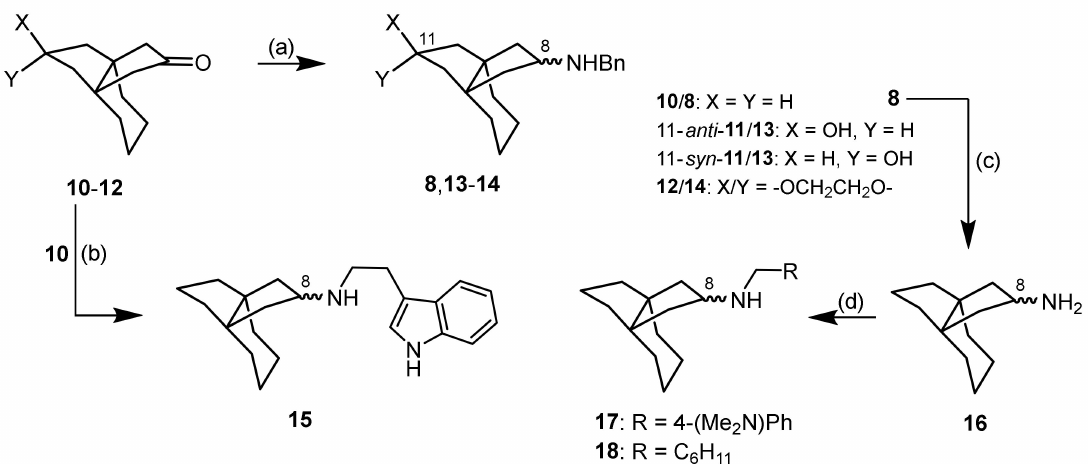
Scheme 2. Synthesis of propellanamines 8 and 13–18 . Reagents and reaction conditions: ( a ) PhCH 2 NH 2 (BnNH 2 ), NaBH(OAc) 3 , HOAc, ClCH 2 CH 2 Cl, rt, 3–8 d, 61–99%; the diastereomeric benzylamines 8- anti - 14 and 8- syn - 14 were separated by fc; 30% (8- anti - 14 , 28% (8- syn - 14 ). ( b ) Tryptamine, NaBH(OAc) 3 , HOAc, ClCH 2 CH 2 Cl, rt, 5 d, rt, 33%. ( c ) NH 4+ HCO 2- , Pd(OH) 2 , CH 3 OH, 65 ◦ C, 3 h, 75%. ( d ) (Me 2 N)C 6 H 4 CH=O or cyclohexanecarbaldehyde, NaBH(OAc) 3 , ClCH 2 CH 2 Cl, rt, 72 h 98% ( 17 ) or 12 h, 91% ( 18